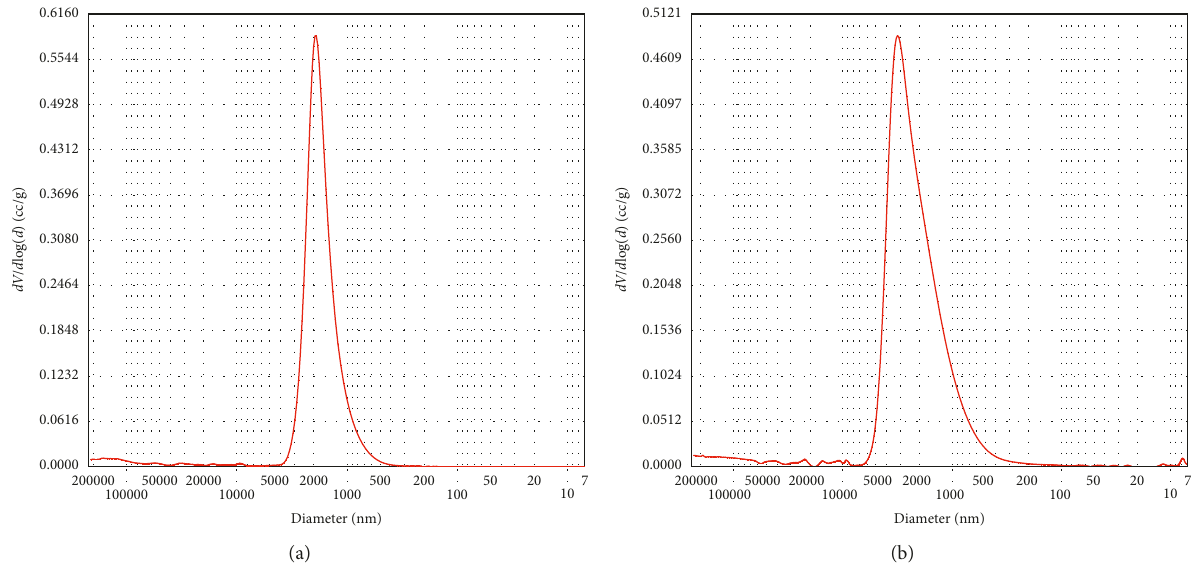
Figure 3: Pore-size distribution of the two membrane: (a) α -Al